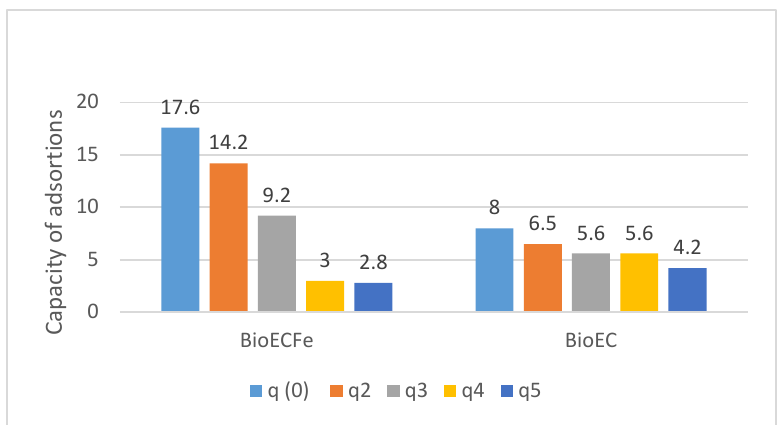
Figure 11. The process of elutions with EDTA. Table 8. Summary of the experiments obtained with EC material.